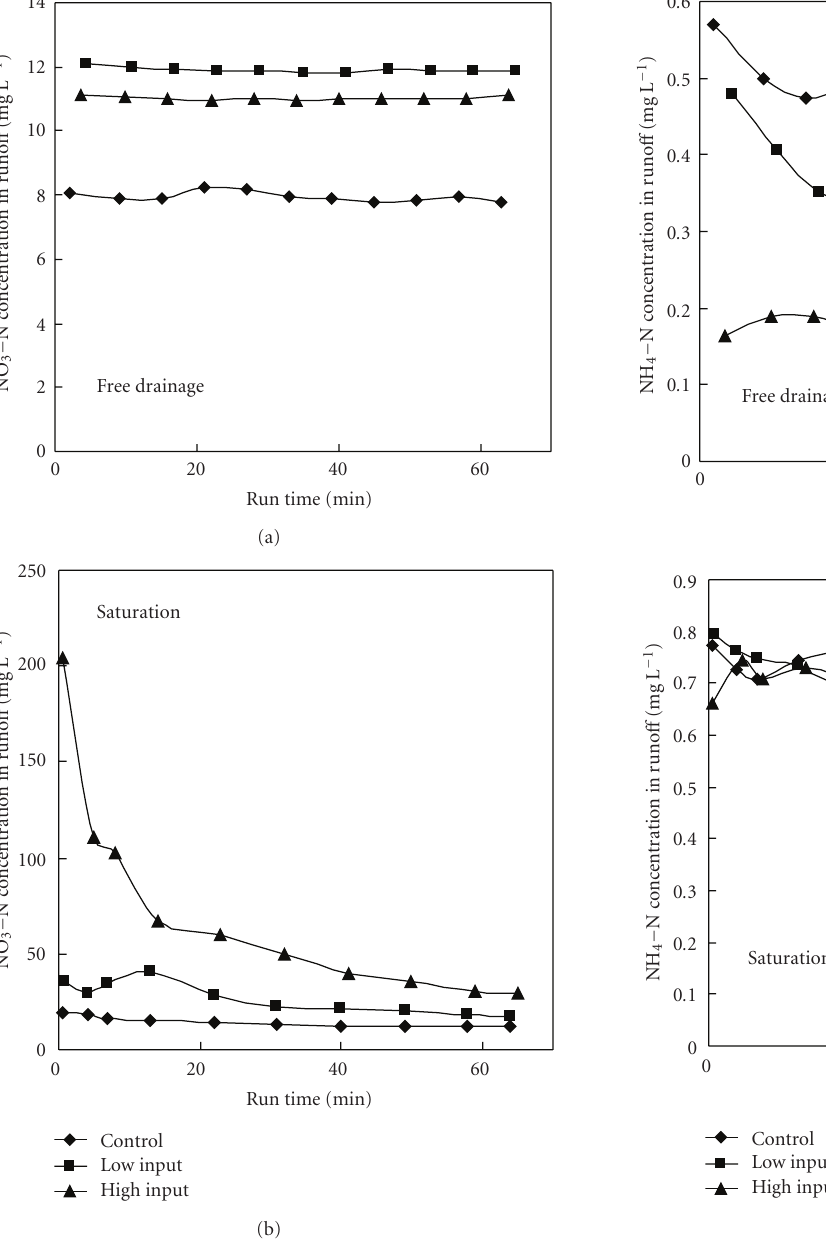
Figure 2: The NO 3 –N concentration in runo ff under di ff erent hydraulic gradients.